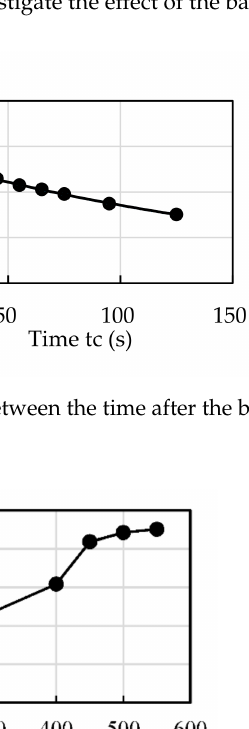
Figure 2. Experimental procedure to investigate the effect of the base strip temperature on bonding.